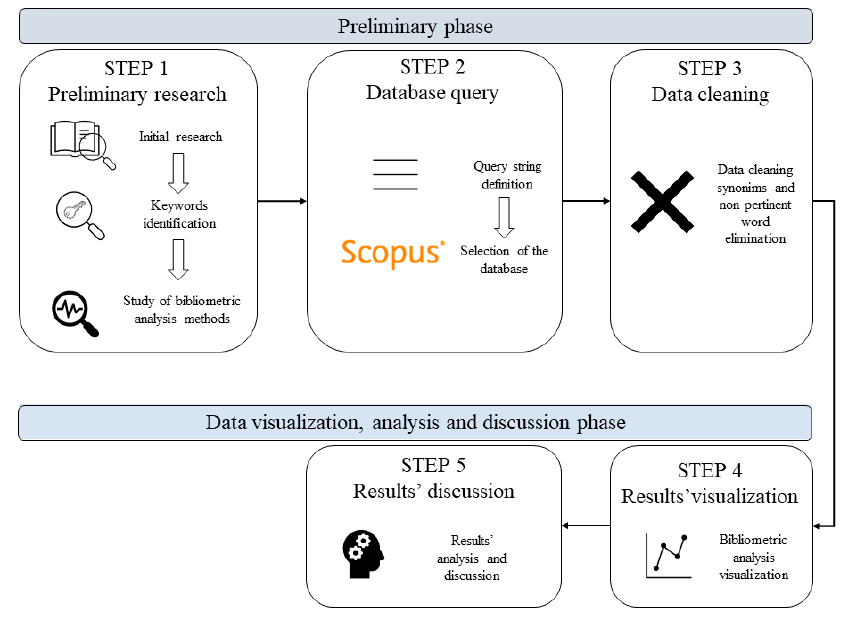
Figure 1. Methodology followed for the bibliometric analysis.